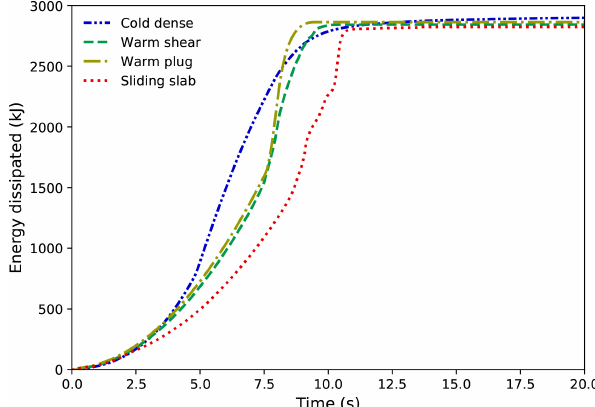
Figure A2. Evolution of dissipated energy of the flows in the four typical flow regimes.